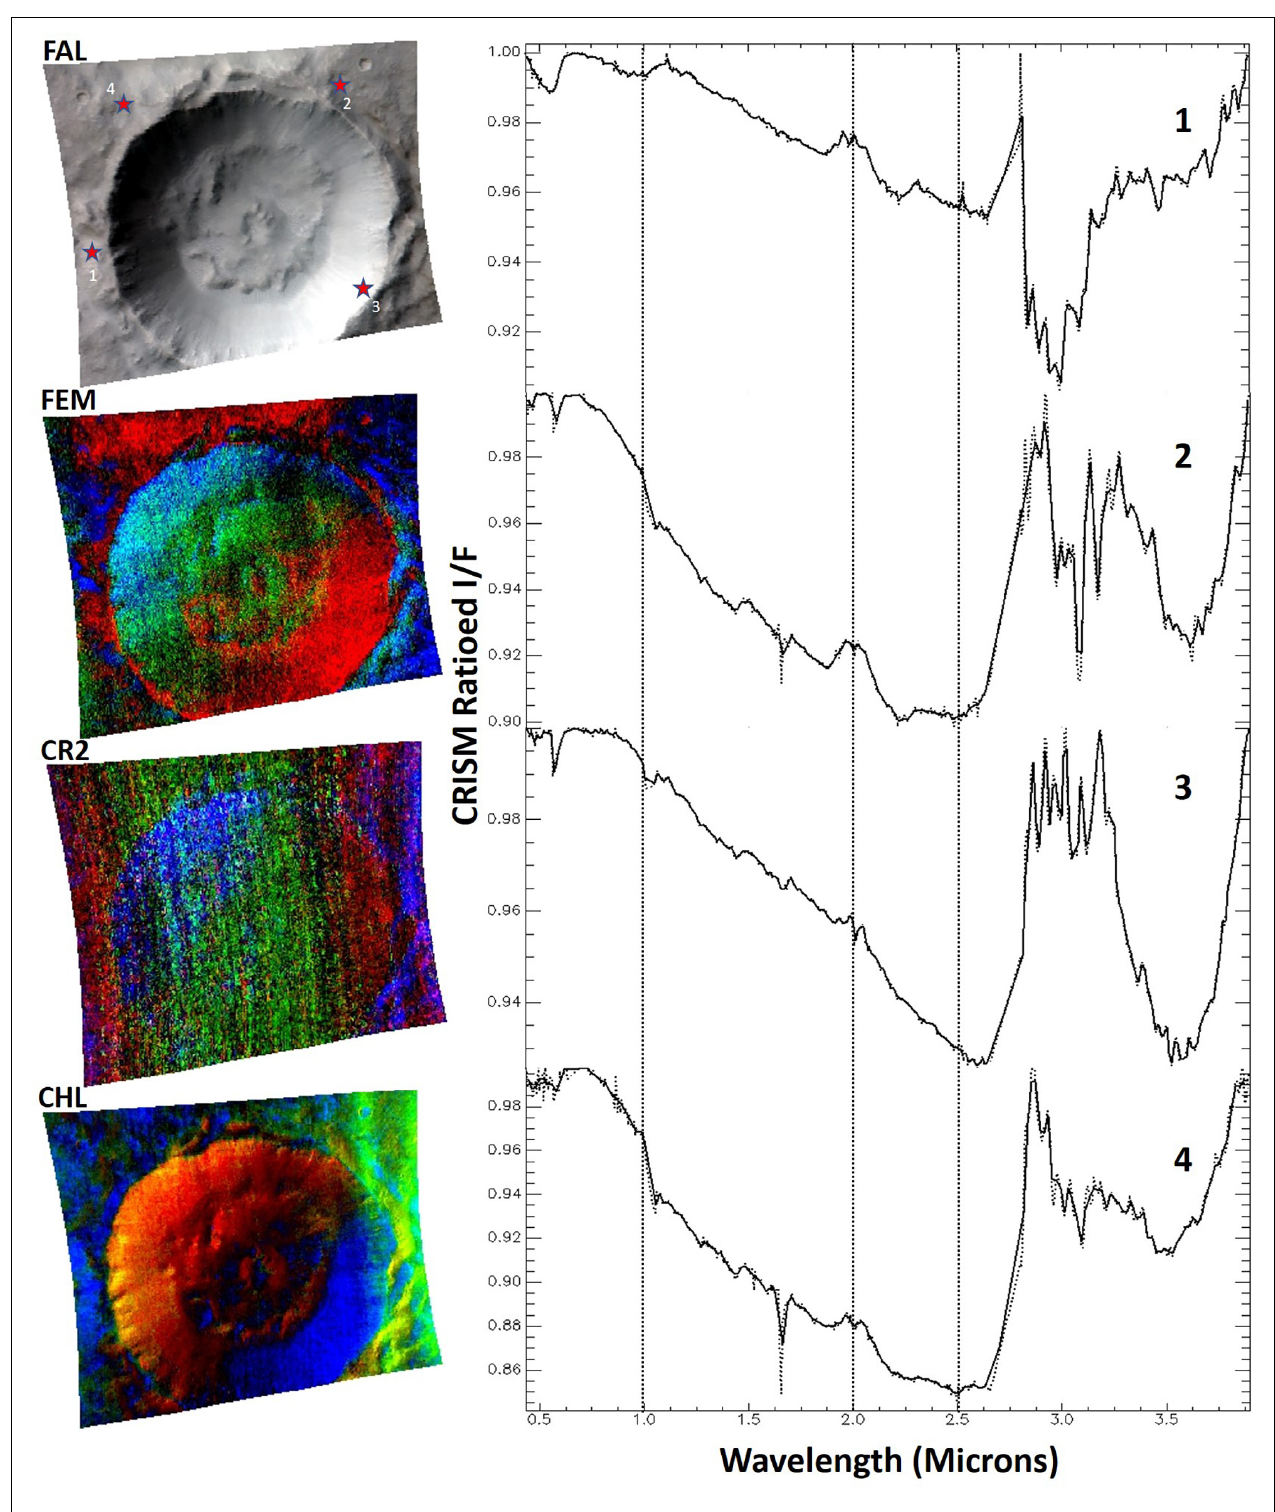
FIGURE 11 | FAL, FEM, CR2, and CHL browse products derived from CRISM data to correlate the map to the surface feature and to assess information regarding ferric and ferrous minerals, carbonate minerals, and chloride deposits. Sample locations are representatively marked in the FAL browse product along with the extracted spectra in Noachian unit Unnamed crater